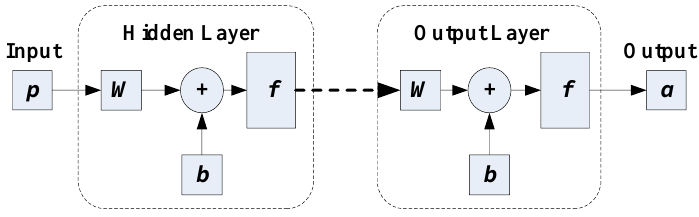
Figure 1. Illustration of the structure of an ANN.